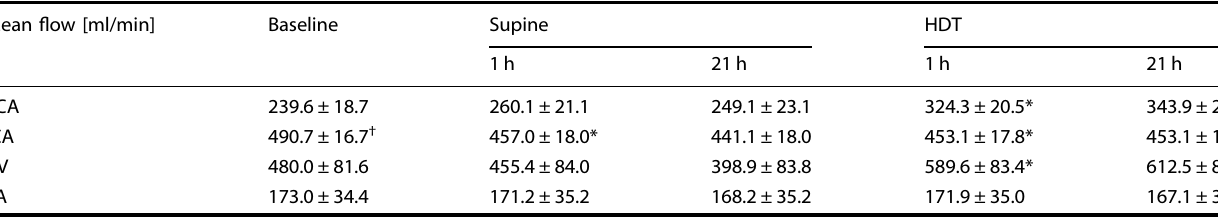
Table summarizing the mean fl ow rate of the internal jugular veins, the external and internal carotid arteries at each of the respective positions and time points.